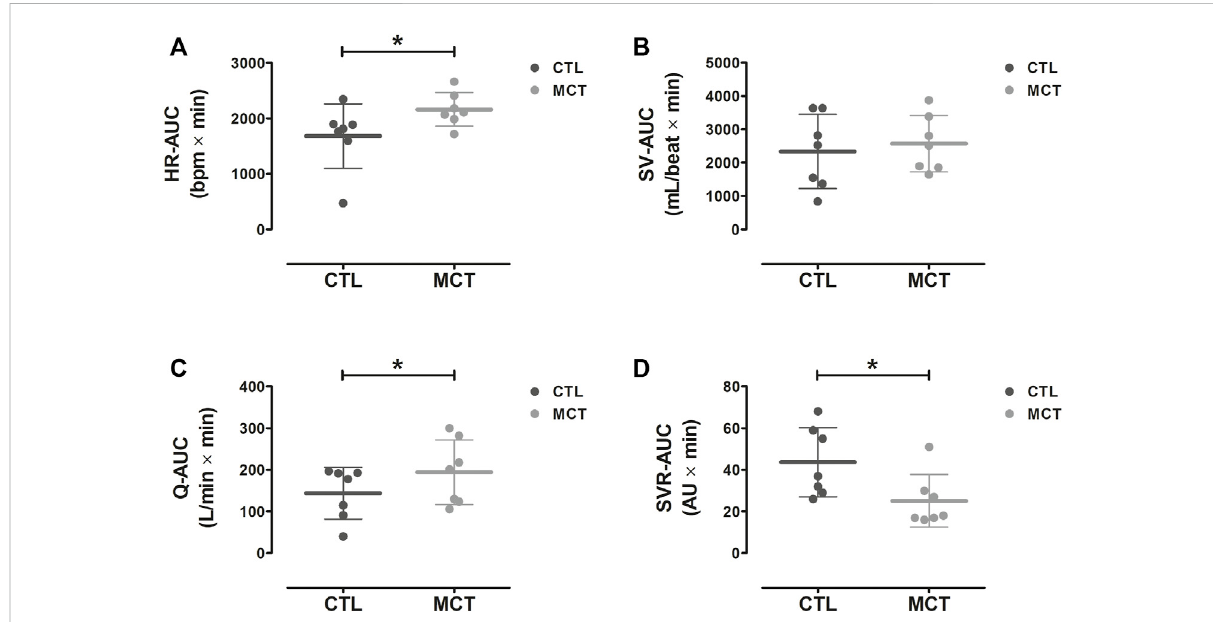
FIGURE 4 Mean ± SD AUCs for HR (A) , SV (B) , Q (C) , and SVR (D) during the fi rst 40 min after the experimental trials. AUC, area under the curve; MCT, mixed circuit training; CTL, non-exercise control session; HR, heart rate; SV, stroke volume; Q, cardiac output; SVR, systemic vascular resistance. *, Signi fi cant difference between CTL vs. MCT ( p < 0.05).